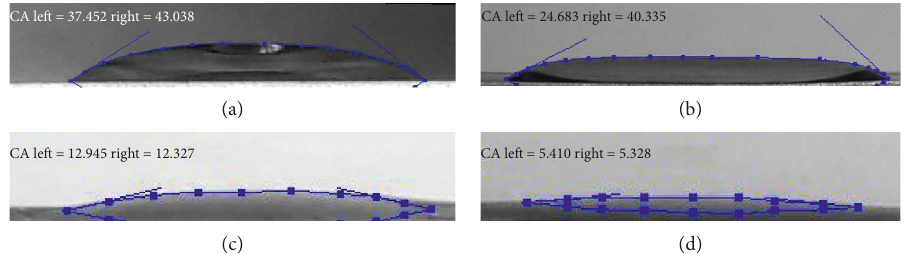
CA left = 5.410 right = 5.328